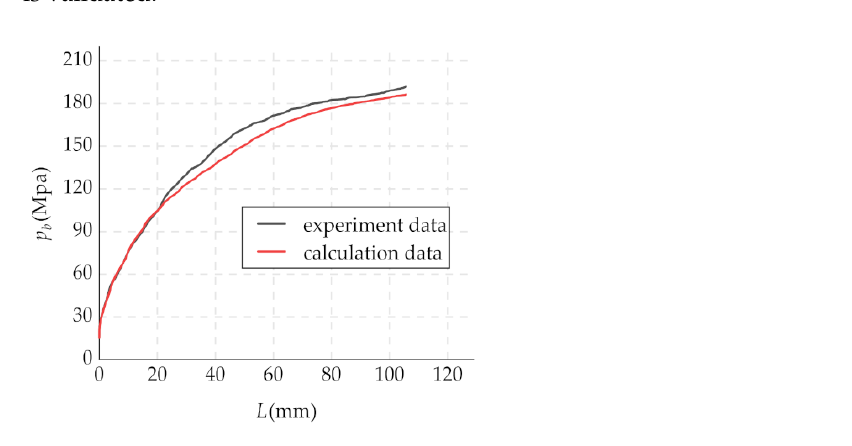
Figure 10. Comparison of displacement–pressure data of the projectile by calculation and